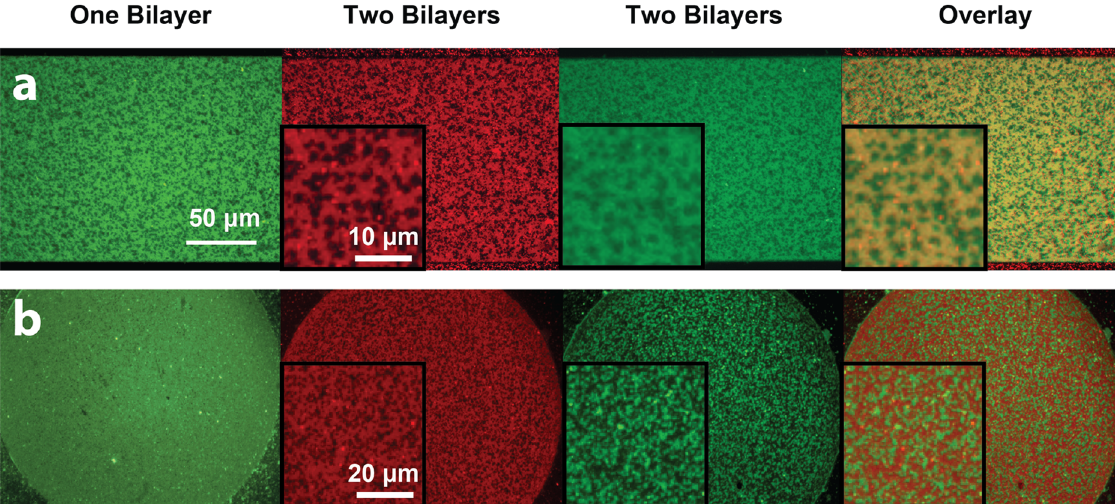
Figure 5. Epifluorescence images of stacked phase-segregated SLB patterns. The first lipid bilayer was composed of DOPC:DSPC:DOTAP:DHPE-OG (green channel), while the second lipid bilayer was composed of DOPC:DSPC:DOPS:DHPE-LR (red channel). Insets show zoomed-in areas of the patterned bilayers. ( a ) When the first bilayer showed good phase segregation (green), the second lipid bilayer would phase segregate in the same pattern (red). The fluorescence intensity of first bilayer would decrease due to FRET, and the overlaid image of the two channels showed alignment of gel phase domains in the two bilayers; ( b ) When the first bilayer did not phase-segregate, the second SLB would still show gel-phase domains. The first bilayer appeared dimmer in areas that overlapped with the liquid disordered phase of the second bilayer. Image contrast has been adjusted to facilitate the visualization of the overlapping patterns in the stacked lipid